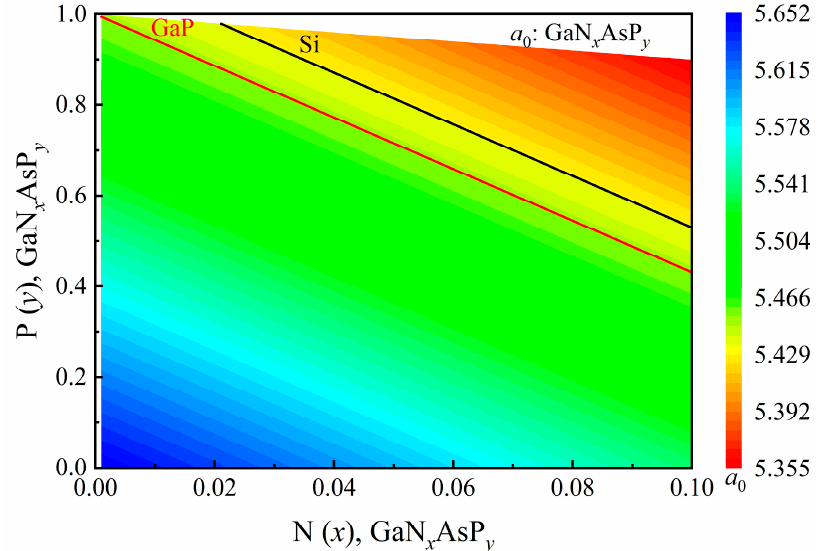
Figure 1. Lattice constant ( a 0 ) variation for GaN x As 1- x - y P y with different mole fractions of N( x ) and P( y ). Redline represents mole fraction combinations to be lattice-matched with Si; black line represents the combinations to be lattice-matched with GaP.